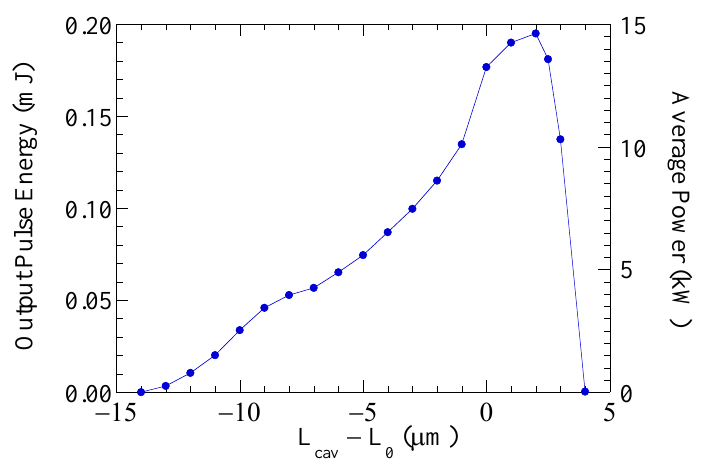
Figure 8. Tuning curve for the IR upgrade experiment. Simulation parameters as described in the text.